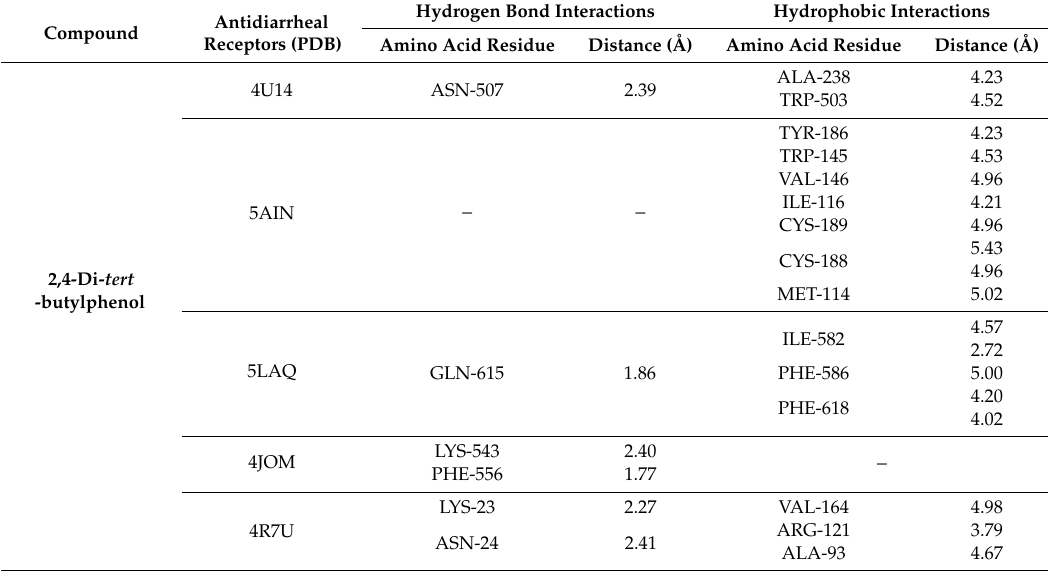
Table 7. Binding interactions of (2,4-di- tert -butylphenol) as identified in the molecular docking study.